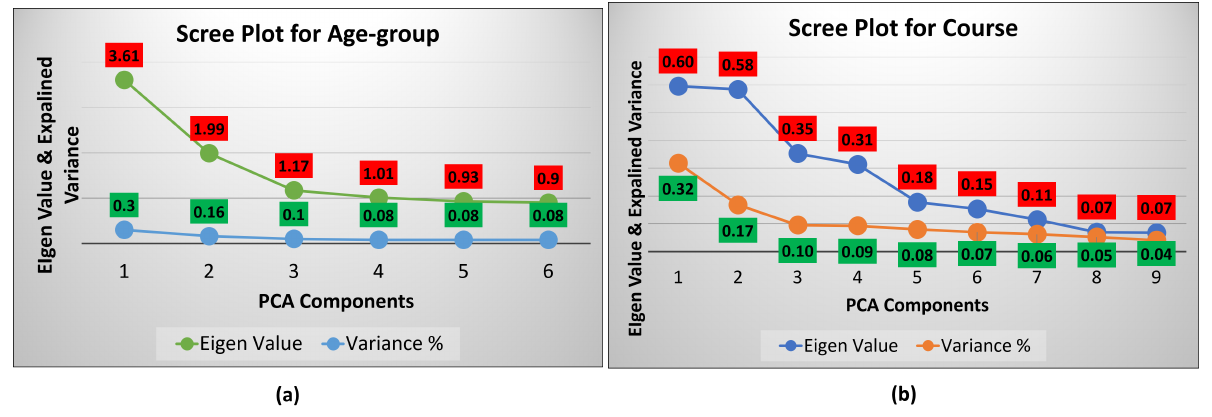
Figure 6. SDI Scree plot ( a ) age-group; ( b )